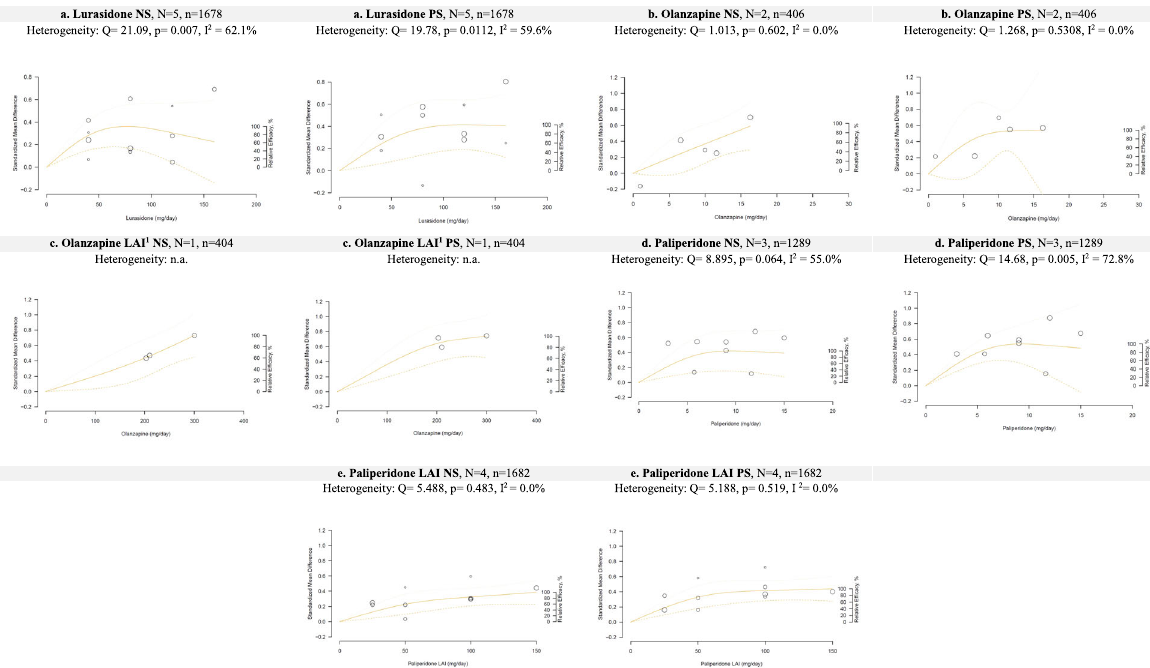
Fig. 2 Dose-response curves for lurasidone, olanzapine, paliperidone regarding negative symptoms (NS) or positive symptoms (PS). (1) In this study, olanzapine LAI doses are used (210 mg and 300 mg each 2 weeks and 405 mg each 4 weeks, that correspond to dosages of 10, 15 and 10 mg per day